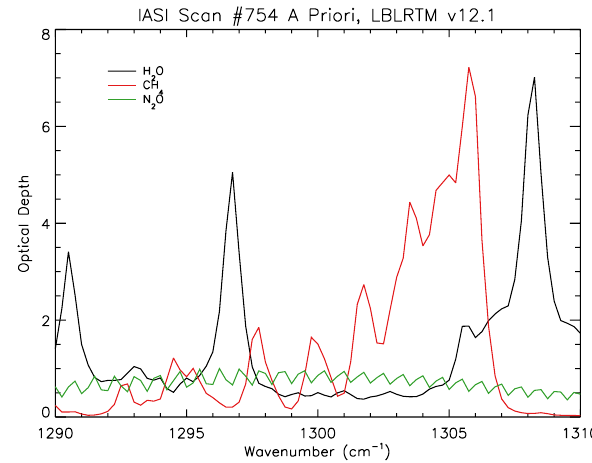
Fig. 30. Convolved optical depth (calculated as the negative of the natural logarithm of the convolved transmittance for LBLRTM runs with a single absorbing gas) of H 2 O (which includes HDO), N 2 O, and CH 4 near the ν 4 band of CH 4